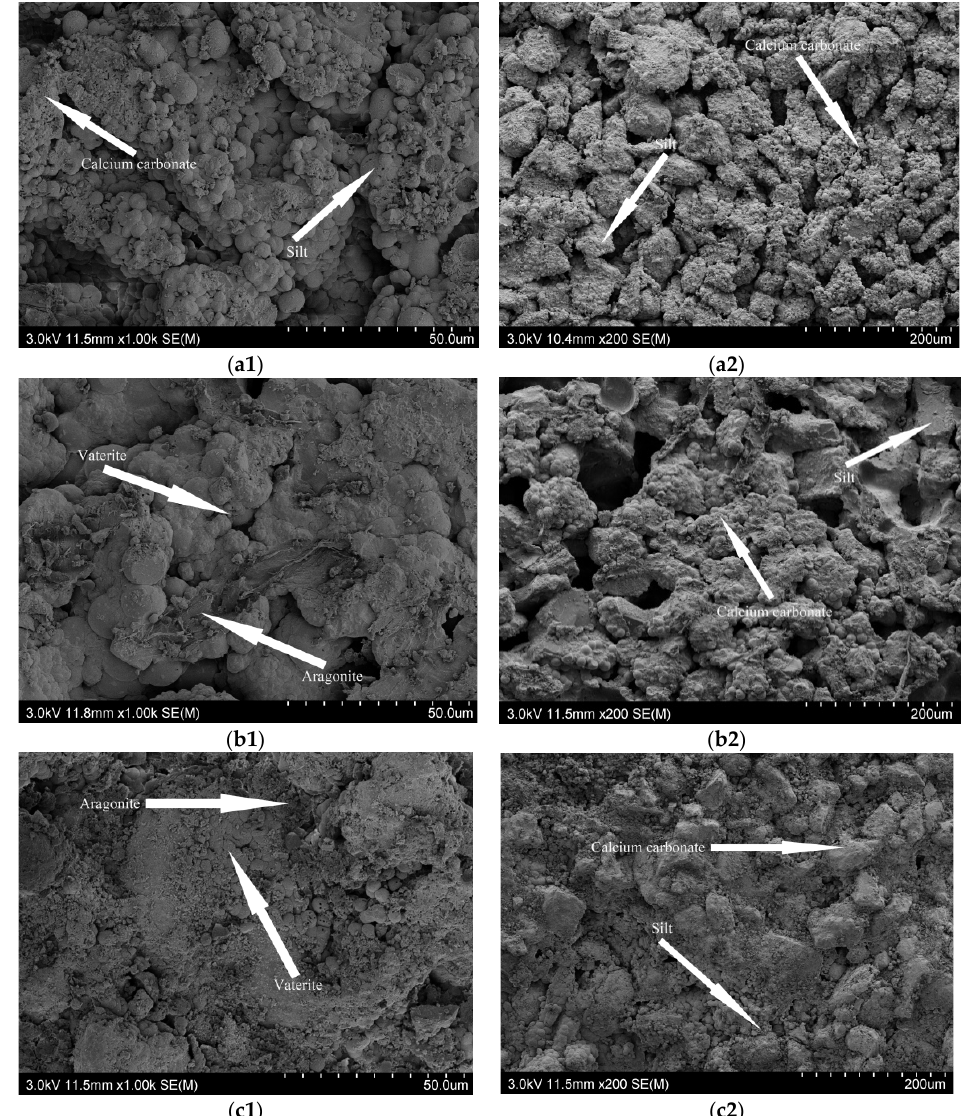
Figure 7. SEM images of different silts. ( a1 , a2 ) SEM image of silt A; ( b1 , b2 ) SEM image of silt B; ( c1 , c2 ) SEM image of silt C.